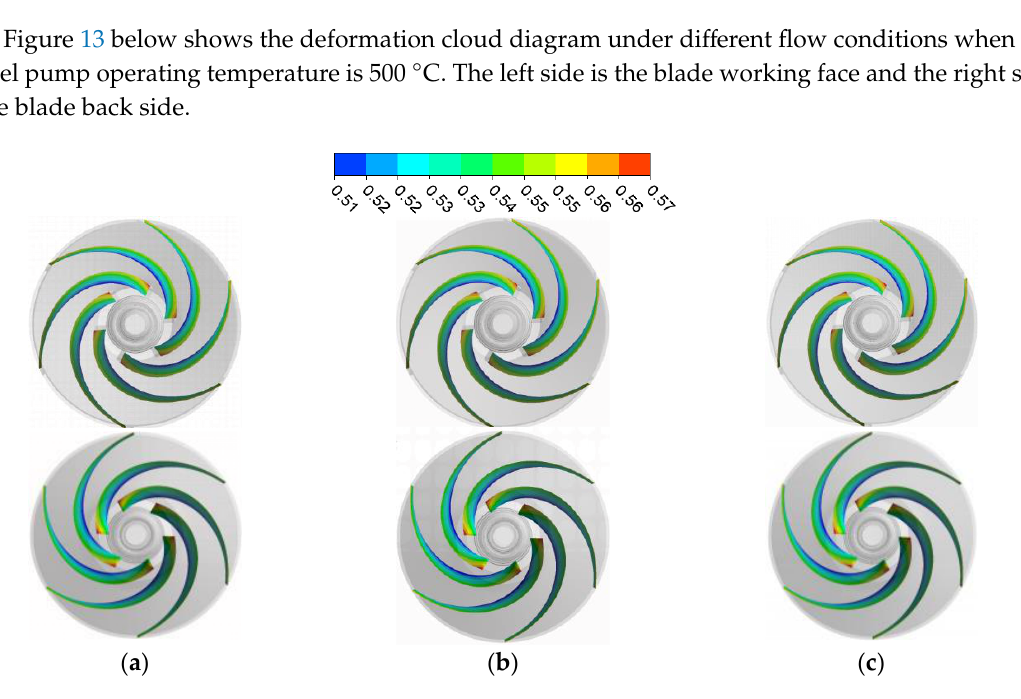
Figure 13. Deformation of fluid-heat-structure interaction in blade at 500 ◦ C, mm. ( a ) 0.4 Q d . ( b ) 1.0 Q d . ( c ) 1.3 Q d .